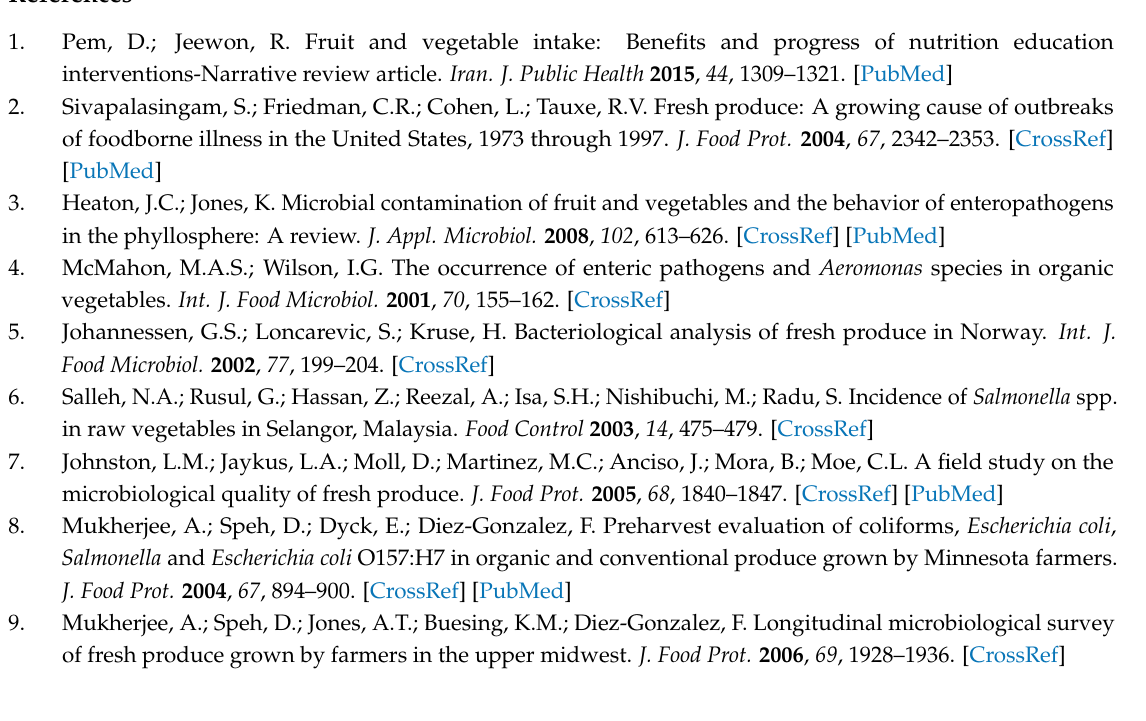
Figure S1: Purified bacterial colonies on LB agar, Figure S2: HCN production by different purified bacterial isolates, Figure S3: Phosphate solubilization by A. caloaceticus Eb-8 on Pikovskaya medium, Table S1: Auxin production and biofilm formation by plant associated bacteria, Table S2: Phosphate solubilization and HCN production by different bacterial